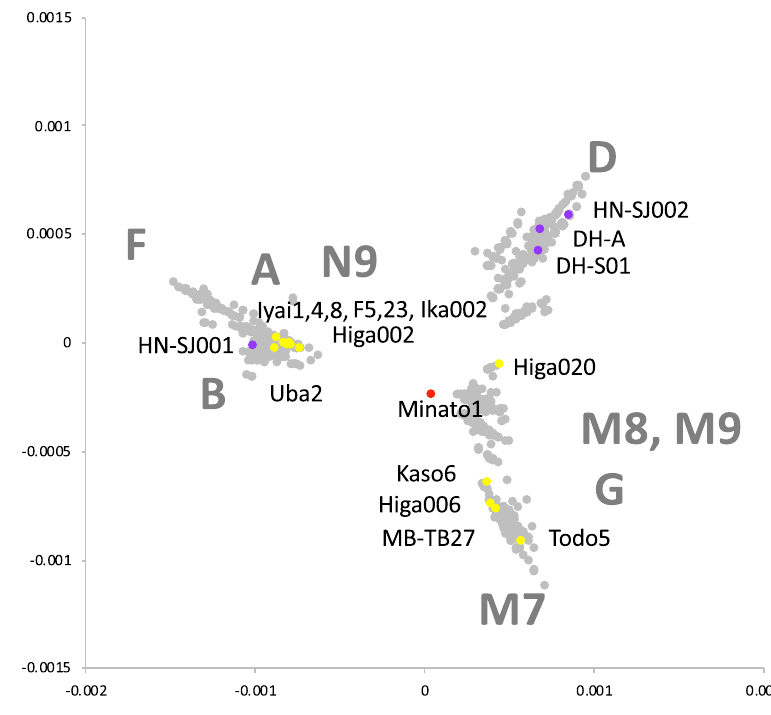
Figure 3. Multi Dimensional Scaling (MDS) plot of whole coding sequences of mitogenome of 1 Palaeolithic (red), 13 Jomon (yellow), 4 Yayoi (purple), and 2,062 present-day (grey) individuals in the Japanese Archipelago. For present-day Japanese, assigned haplogroups were